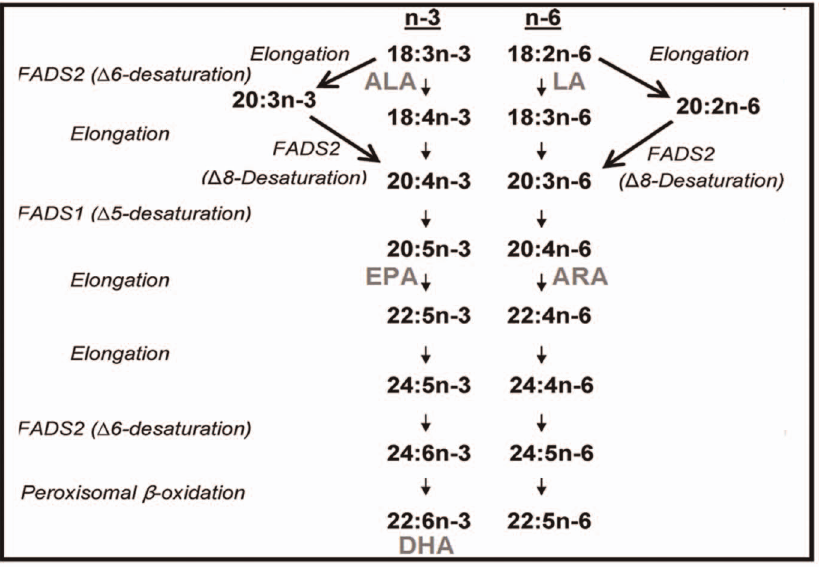
Figure 1. Endogenous pathway for LC-PUFA synthesis DHA, EPA and ARA by enzymatic desaturation and chain elongation steps.